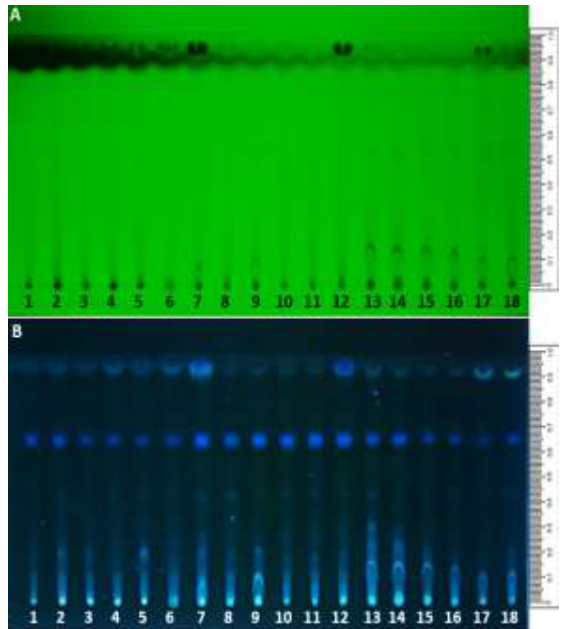
Figure 2. Effect of light during fermentation on TLC profile of ethyl acetate extract from broth medium of E.linearis . A. Observed under UV 254 light. B. Under UV 366 light. All were performed in